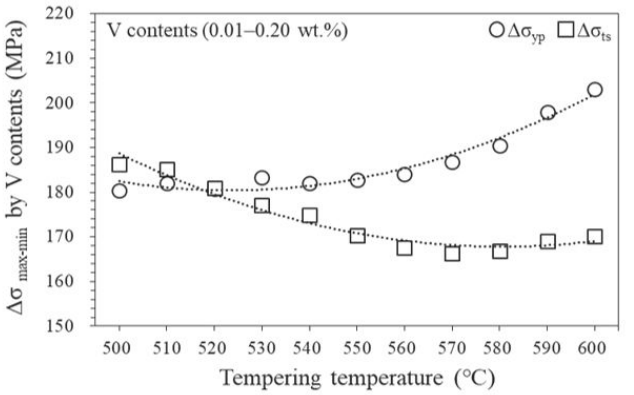
Figure 11. Increase in yield and tensile strengths predicted by ANN as a function of the self-tempering temperature in the regime of V contents (0.01–0.20